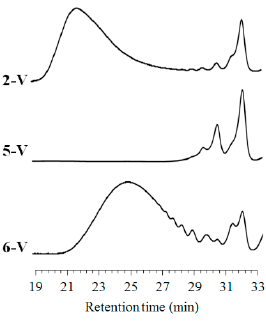
Figure 3. SEC traces of 2-V , 5-V , and 6-V . Table 2. Condition and results for the ring-contraction radical crossover reaction and subsequent second ring-expansion radical crossover reaction.